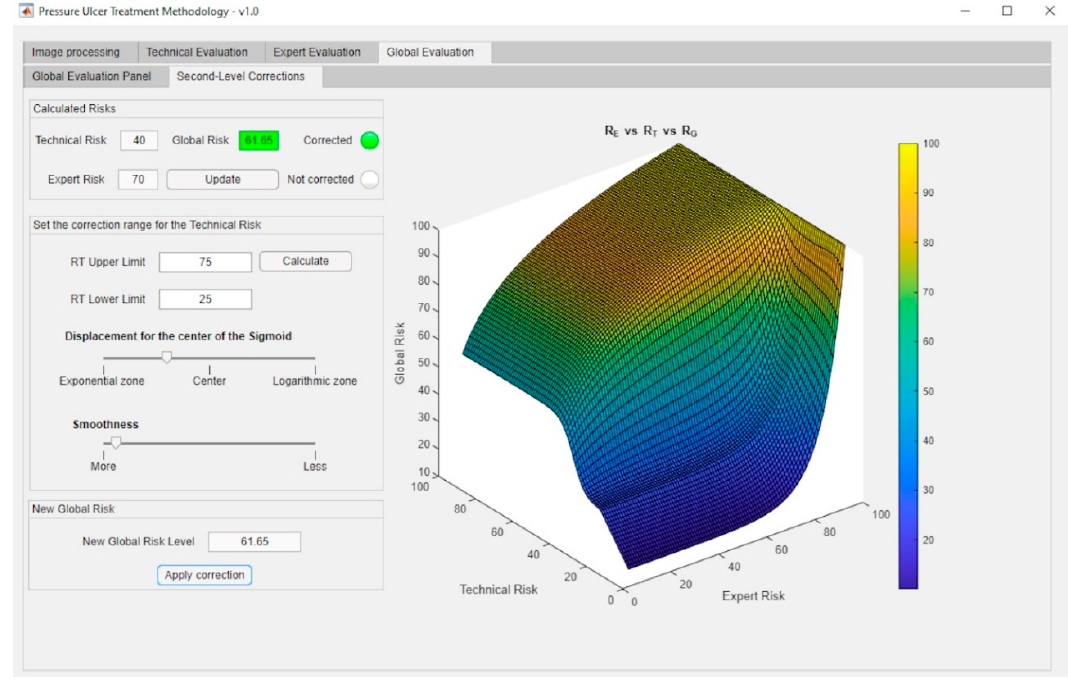
Figure 25. Second-level correction.